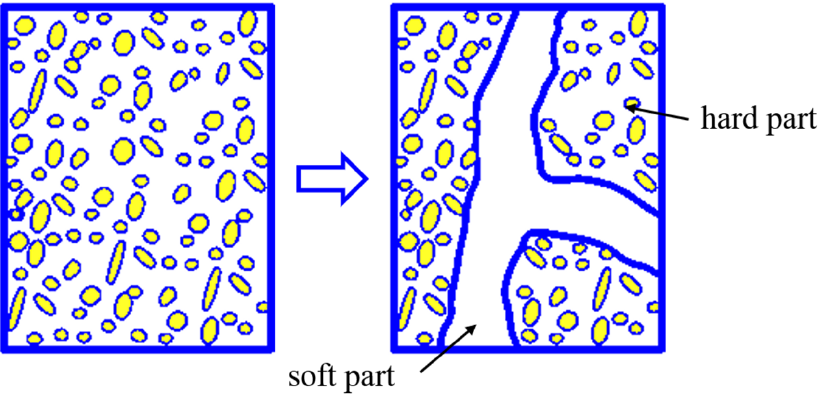
Figure 2. Conceptual model for fracture evolution in fractured shale.